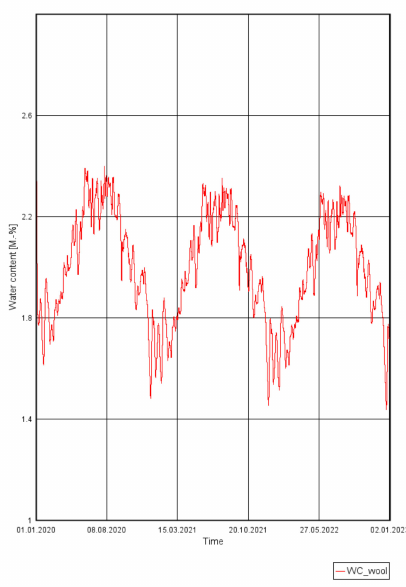
Figure 24. Changes in water content in the insulation material layer—mineral wool.